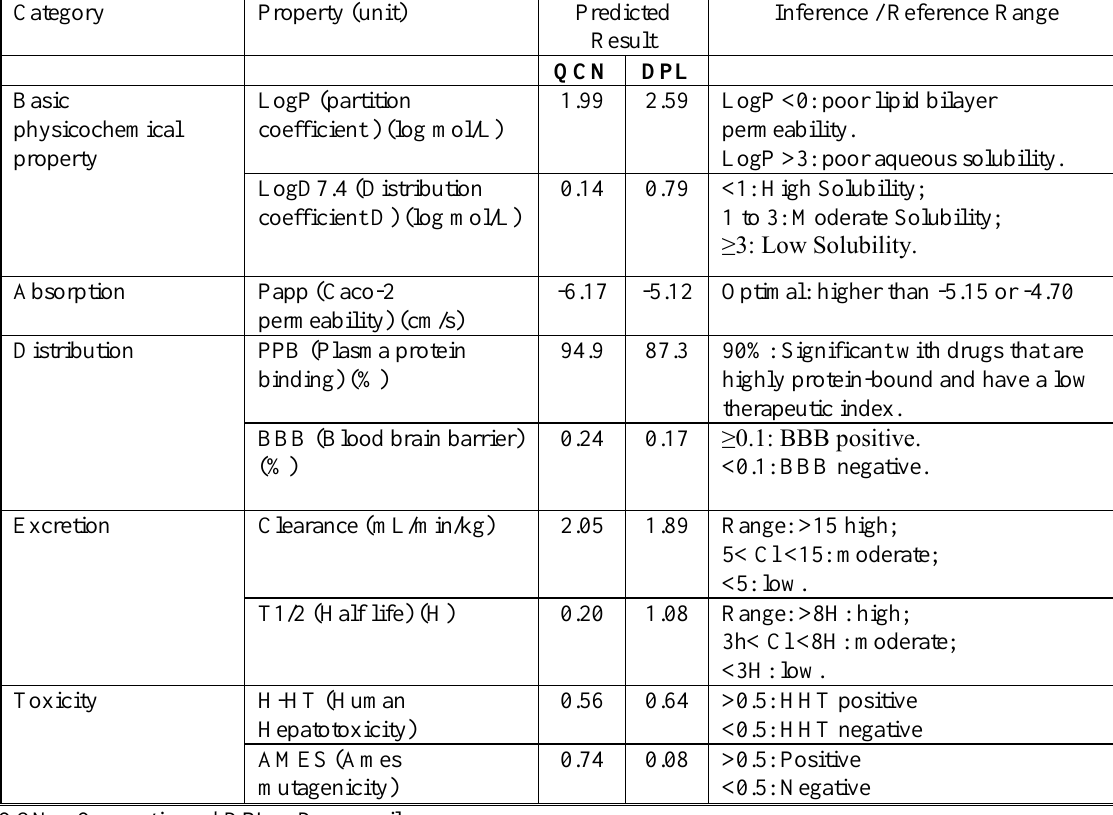
Table 2. In silico Toxicity and Pharmacokinetic Prediction Profile on Quercetin and its. Category